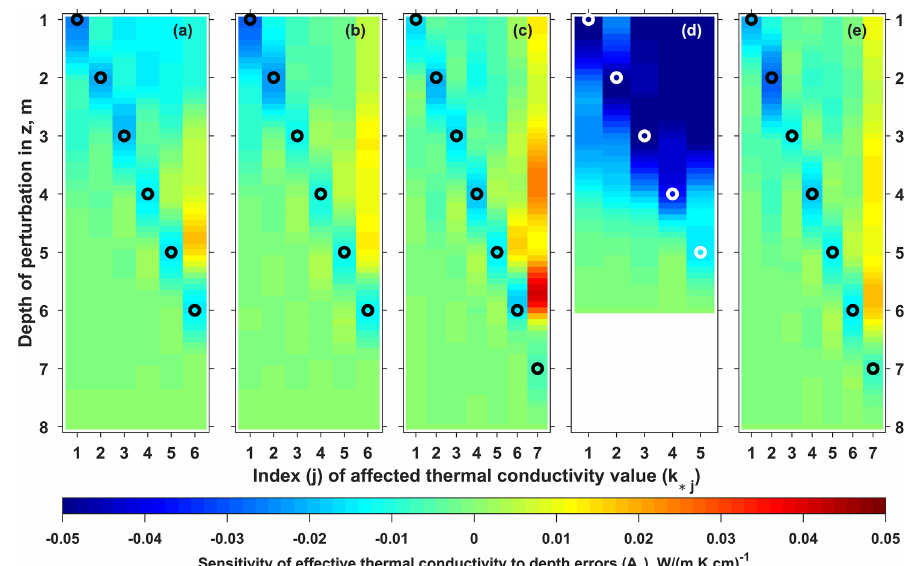
Figure 6. Sensitivity ( A z in Eq. (21)) of effective thermal conductivities k ∗ j to errors in depths of temperature values. Panels correspond to different calculation domains: spring 2012 (a) , spring 2013 (b) , spring 2014 (c) , autumn 2014 (d) and spring 2015 (e) . In all panels the colour of a point in column j and depth z shows the feedback on effective thermal conductivity value k ∗ j found at the depth highlighted by the black (white in d ) circle to an error in depth of temperature value (1cm) made at depth z . Table 1. Expected deviations of thermal conductivities ( E [ δk ] in Eq. 22) and the corresponding standard deviations ( 24) given the magnitude of thermistor string coiling in the boreholes is expressed by L = 1m (see Eq. 25) and σ z =